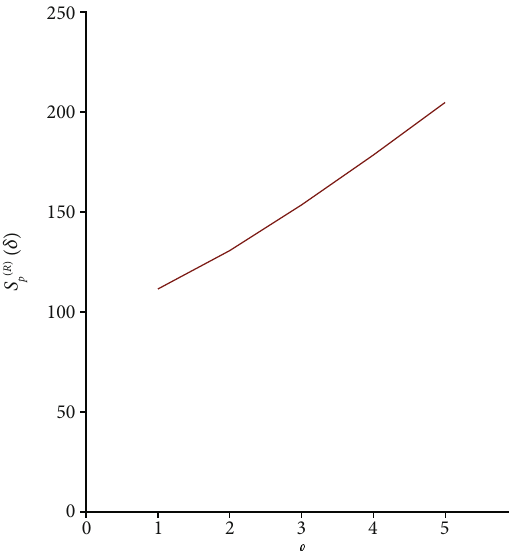
Figure 7: Contribution of the σ -parameters to the energy spectra with μ = c = ℏ = 1 , Η = 40 , D = 3 , T = 0 : 5 , and ϱ = 0 : 5 for n = 1 , 2, 3, 4, and 5 .